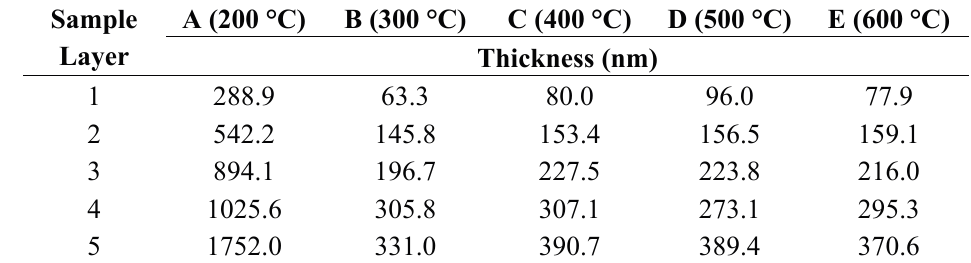
Table 3. Thickness of prepared samples as determined by mechanical